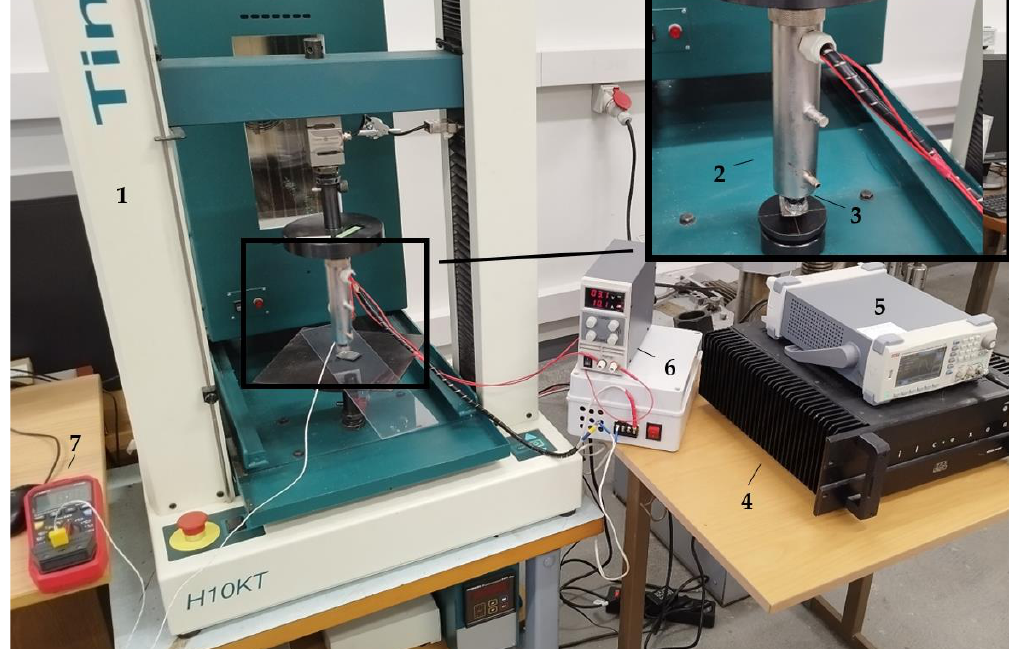
Figure 7. Microstructure forming equipment: 1 — Tensile test machine H10KT (Tinius Olsen, Horsham, JAV), 2 — magnetostrictor, 3 — forming grid, 4 — amplifier PA8HF (Wilcoxon, Gamlingay, England), 5 — signal generator UTG2025A (UNI-T, Hong Kong, China), 6 — power source KPS3010D (wanptek, Shen Zhen, China), 7 — thermometer UT161D (UNI-T, Hong Kong, China).